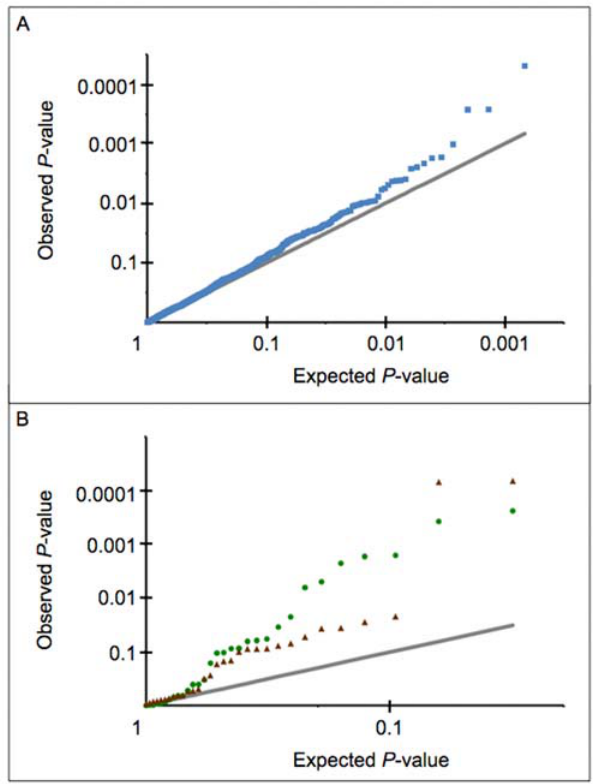
Figure 3. Quantile-quantile (Q-Q) plots comparing the distri- butions of observed versus expected P -values. (A) shows the LD mapping Q-Q plot. The blue squares represent the observed P -values. The grey line represents the null hypothesis of no true association. (B) shows the extension study mapping Q-Q plot. The green circles and the red triangles represent the observed P -values for the family-based and case/control studies respectively. The grey line represents the null hypothesis of no true association.